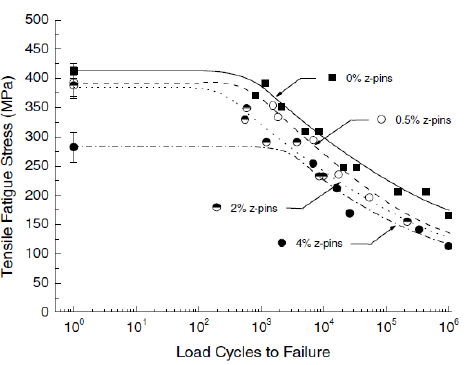
Figure 42. S-N curve for z-Pinned composite subjected to cyclic tension-tension (CFRP z-Pins, F igure 41. S-N curve for a z-Pinned F igure 42. S-N curve for z-Pinned d = 0.28 mm, [0 / 90] pre-preg) composite subjected to cyclic tension- composite subjected to cyclic tension- tension (CFRP z-Pins, d = 0.28 mm, [0] pre- tension (CFRP z-Pins, d = 0.28 mm, [0/90] preg) [1].